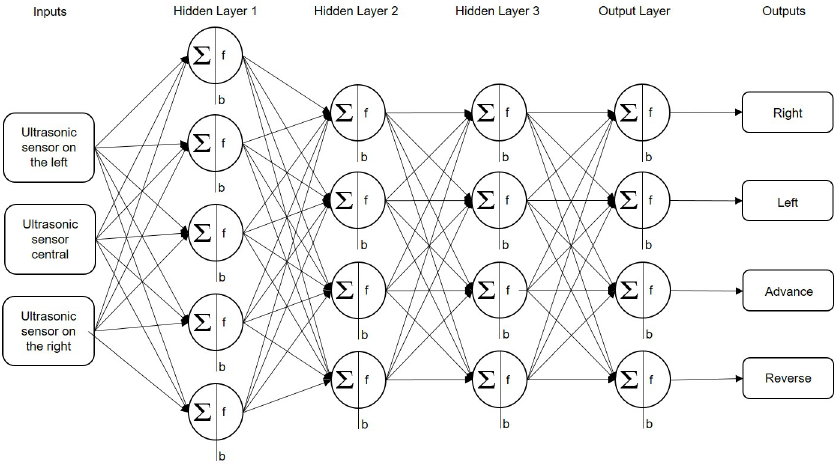
Figure 10. Network structure using a three-input neural network and a 4-element vector